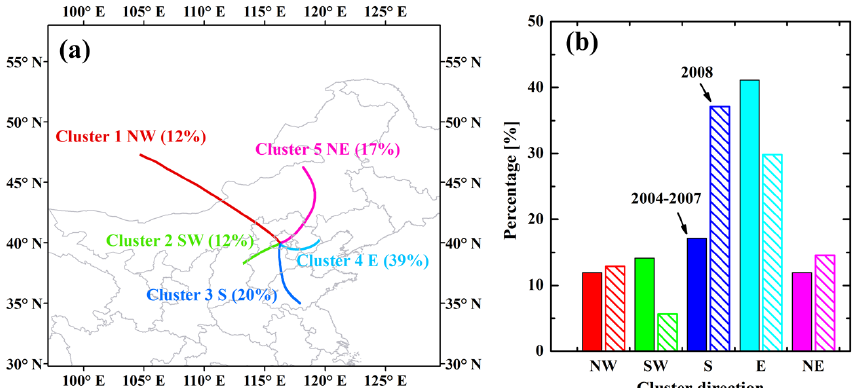
Fig. 4. Mean back trajectories for five trajectory clusters arriving at the PKU site in August 2004–2008 (left panel) and the mean frequencies of five trajectory clusters from 2004 to 2007 and 2008 (right panel). The directions of five trajectory clusters are northwest (NW, red), southwest (SW, green), south (S, blue), east (E, cyan) and northeast (NE, pink), respectively.